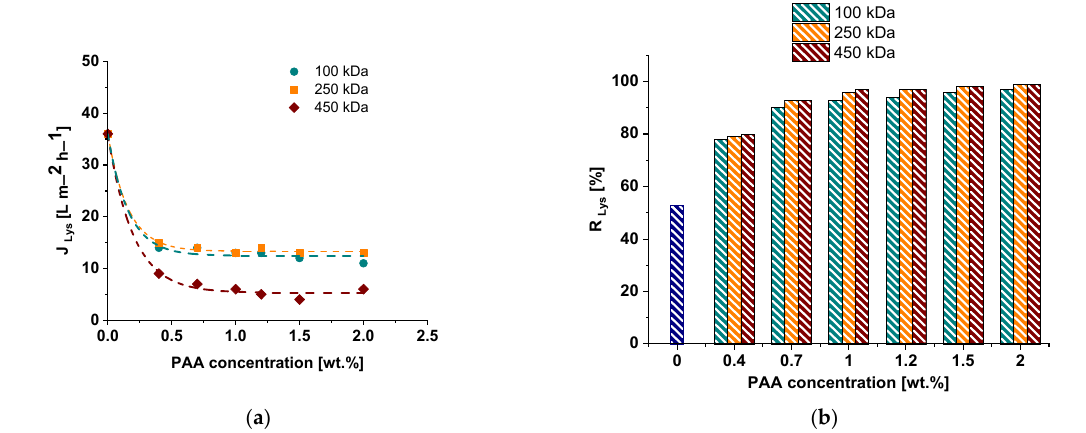
Figure 9. The dependence of 0.5 wt.% lysozyme solution flux ( a ) (J Lys ) and lysozyme rejection coefficient ( b ) (R Lys ) on the PAA concentration in the coagulation bath.